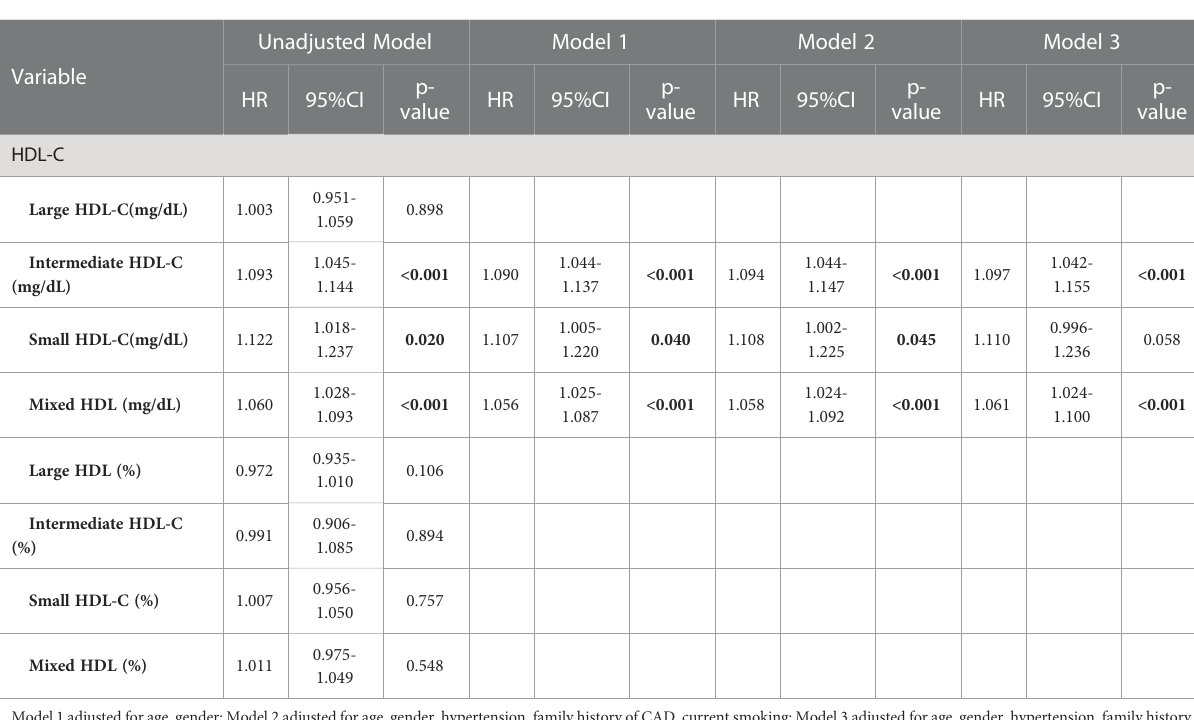
TABLE 5 Cox regression models of HDL subfractions as predictors for CVEs in T2DM and SCAD patients.